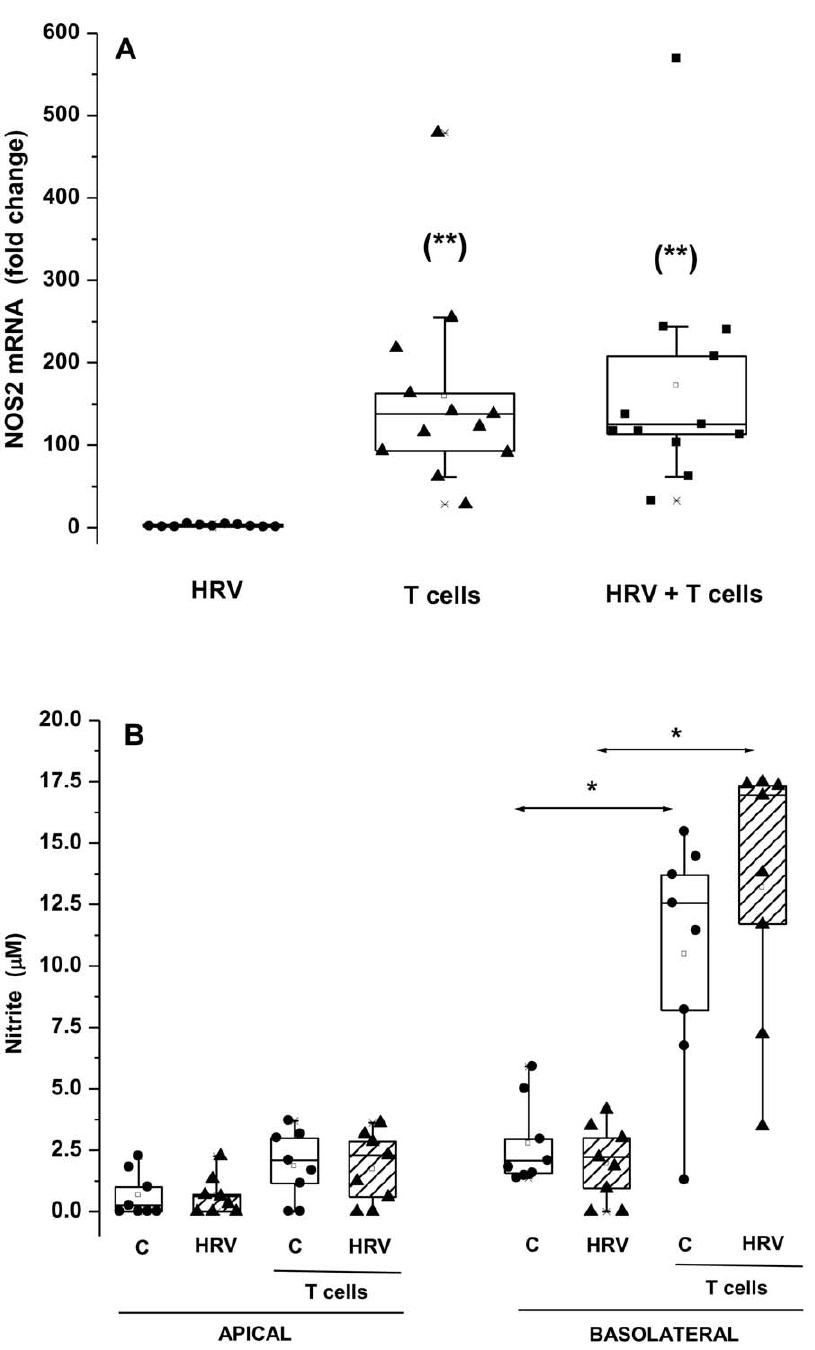
Figure 1. Epithelial NOS2 mRNA expression and NO release are induced by T cells but not HRV14. HNEC were either not infected (C) or exposed apically to HRV14 alone (HRV), or co-cultured with activated T cells alone (T cells), or exposed to HRV14 washed thoroughly then co-cultured with activated T cells (HRV + T cells). (A) mRNA was determined by real-time PCR and data represented as fold increase relative to non-infected cells cultured without T cells. (B) NO secretion is expressed as the amount of nitrite (the stable oxidation product of NO) released in the apical and basolateral compartments ( m M). Shown are the boxplots with the 25 th , 50 th (median), 75 th percentiles, the mean (open square), the maximum and the minimum values. *p , 0.05. **p , 0.05 compared with HRV-infected cells. We developed an in vitro model with primary fully differentiated nasal epithelial cells cultured on semi-permeable membranes which separated them from the co-cultured T cells. Our data revealed active cross-talk between epithelial cells and T lympho- cytes, which impacted inflammation and virus clearance.